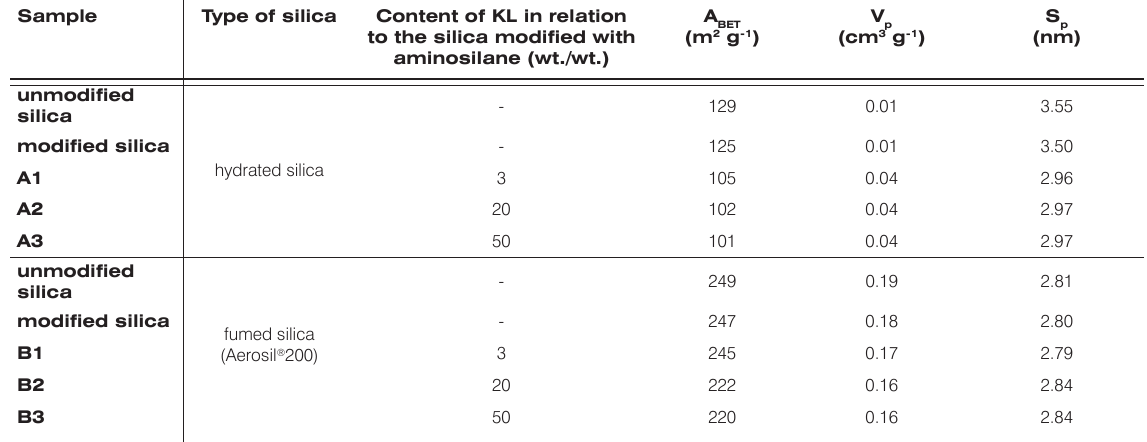
Table 3. Parameters of porous structure properties of both unmodified and silane–modified silicas and silica/lignin hybrid biomaterials. Sample Type of silica Content of KL in relation to the silica modified with aminosilane